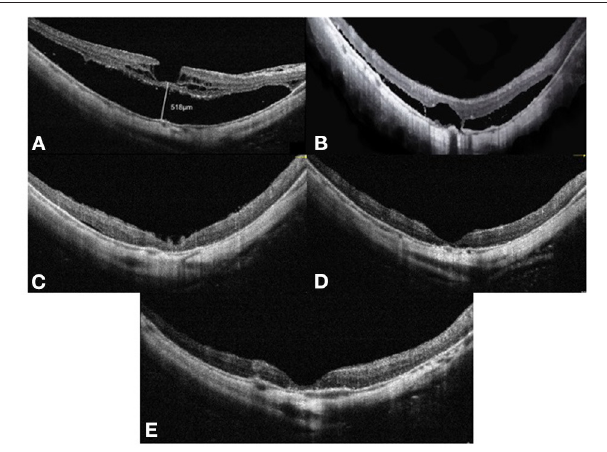
FIGURE 3 | OCT images of case 3. Right eye with a refractive error (spherical equivalent) of − 12.0 diopters in a 65-year-old female: (A) Preoperative OCT image showing retinoschisis and foveal detachment, with a height of 518 µ m. (B) OCT image at 3 months after vitrectomy with SO tamponade showing a moderate foveoschisis and FD resolution. (C) OCT image at 8 months after SO tamponade showing a remarkable foveoschisis and FD resolution. (D) OCT image at 12 months after vitrectomy with SO tamponade showing a complete foveoschisis and FD resolution. (E) OCT image at 3 months after SO surgical removal does not show MF relapse. OCT, optical coherence tomographic; FD, foveal detachment; SO, silicone oil.